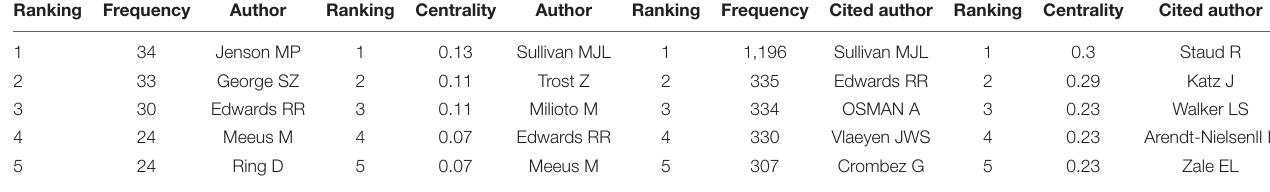
TABLE 5 | The top five authors and cited authors related to pain catastrophizing.